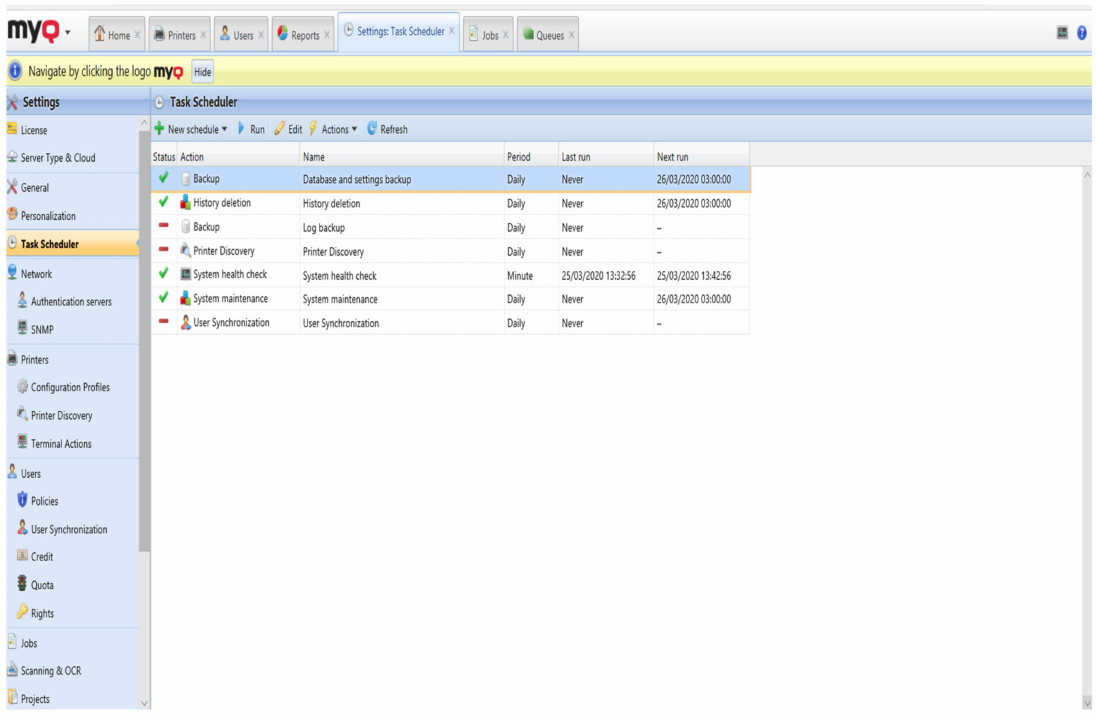
Figure 6. Setting up the task scheduler (creating recurring actions). Source: custom